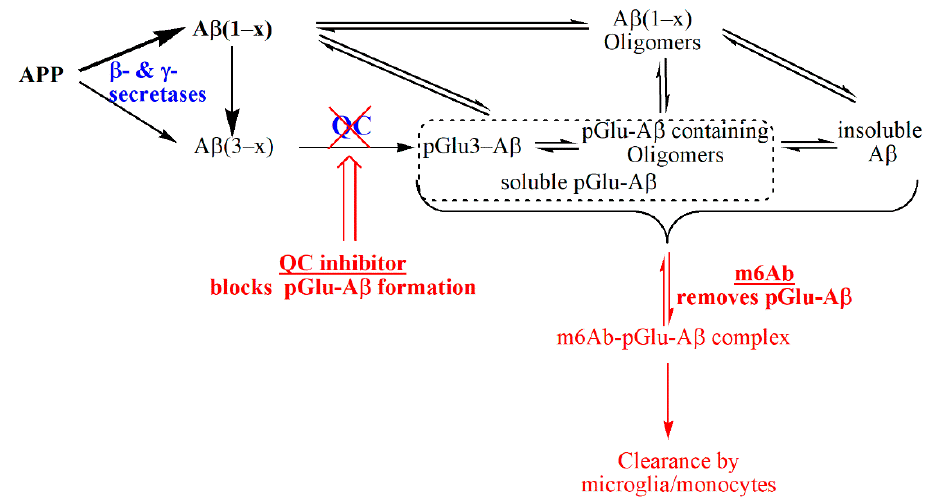
Figure 3. Schematic representation of the molecular pathways for reduction of pGlu3-A β by QC inhibition and anti-pGlu3-immunotherapy (m6Ab). The current study supports the concept that both strategies act independently and are additive. The formation of pGlu-A β occurs after APP cleavage by sheddases such as BACE1 or meprin β , which may lead directly to N-truncated A β forms and the pGlu3-A β precursor, A β (3–x). While QC inhibition prevents de novo-synthesis of pGlu3-A β , which reduces formation of toxic oligomers and coaggregation with other A β forms, the pGlu3-A β specific antibody prevents aggregation and elicits clearance of extracellular, soluble pGlu3-A β containing aggregates by opsonization and phagocytosis by microglia and/or monocytes.